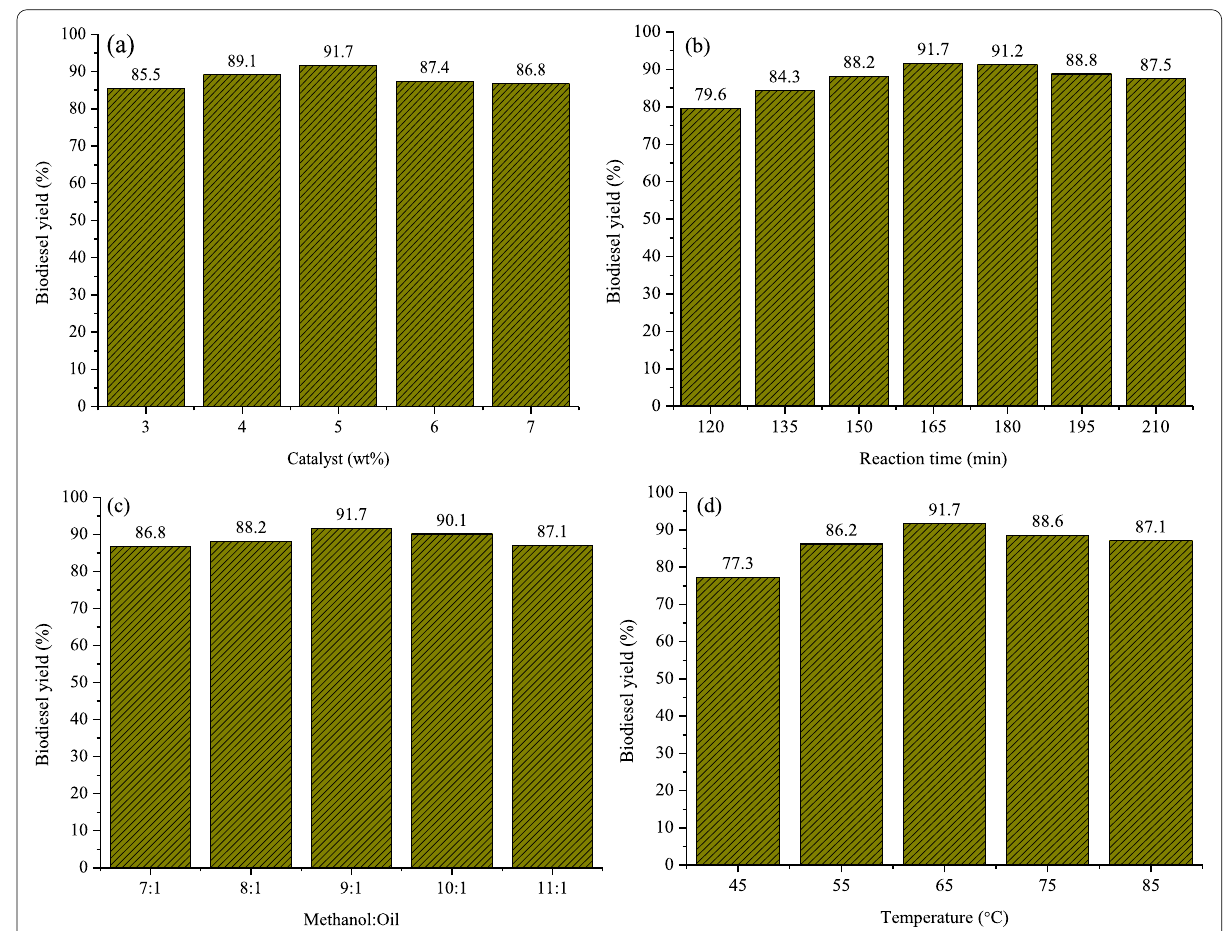
Fig. 3 Effects of a catalyst loading, b reaction time, c methanol to oil molar ratio (MTOMR), and d reaction temperature on biodiesel yield. Conditions: MTOMR 9:1; catalyst loading 5 wt%; reaction time 165 min; 65 ºC; microwave power of 800